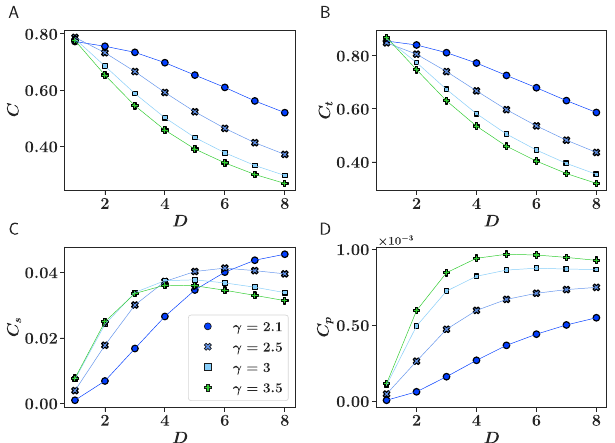
Fig. 1 | Maximum clustering as a function of the dimension. Maximum value of node clustering ( A ), and mean density of edge triangles ( B ), squares ( C ), and pentagons ( D ), as a function of the dimension D and power law exponent γ in syntheticnetworksgeneratedbythe S D model.Valuescorrespondtoaveragesover 100networkrealizationsofsize N =1000and β = ∞ .Theerrorbarsaresmallerthan symbol sizes. The value of μ in Eq. (1) was adjusted so that the observed average degree was < k >=10 : 0±0 : 1 in all